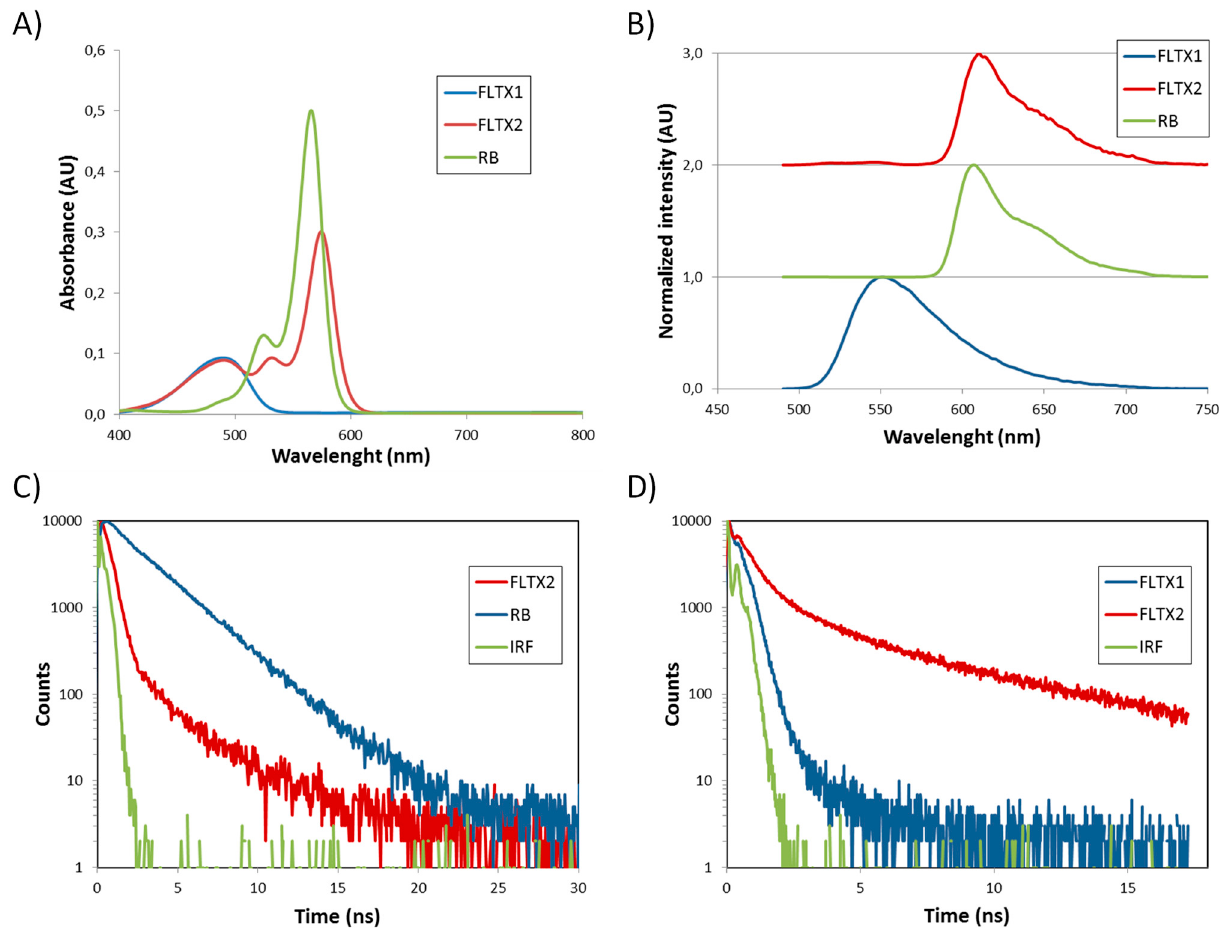
Figure 5. Optical properties of FLTX2. ( A ) Absorption spectra of FLTX1, RB, and FLTX2. ( B ) Normalized emission spectra of FLTX1, RB, and FLTX2. ( C ) Decay of the fluorescence of RB and of FLTX2 with detection tuned at 608 nm. ( D ) Decay of the fluorescence of FLTX1 and of FLTX2 with detection tuned at 550 nm.